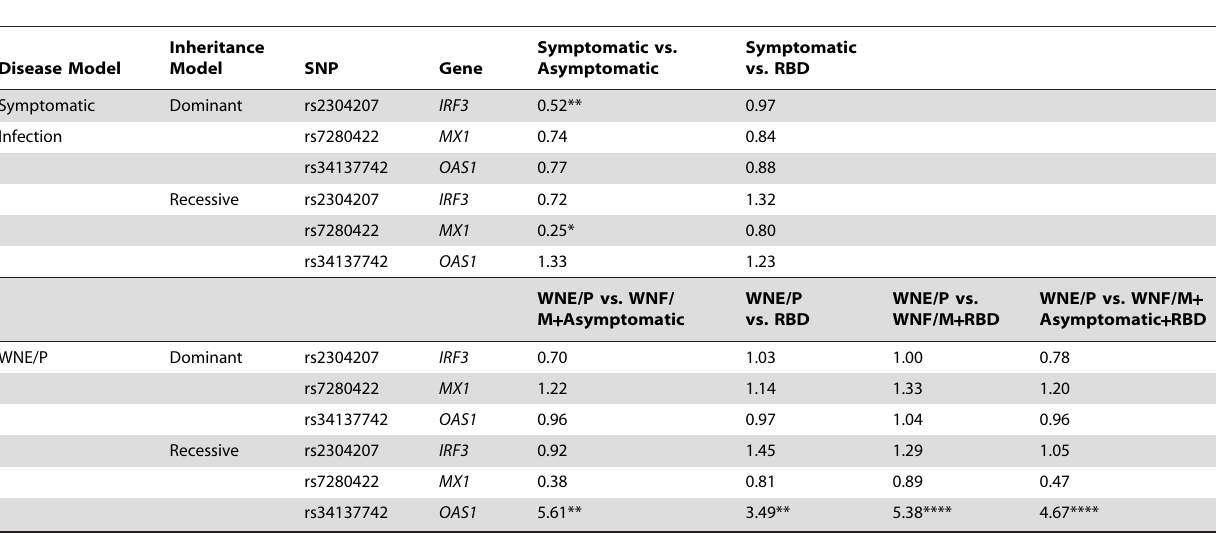
Table 2. Contingency table analysis odds ratios (OR) of significant SNPs associated with WNV symptomatic infection or West Nile encephalitis/paralysis